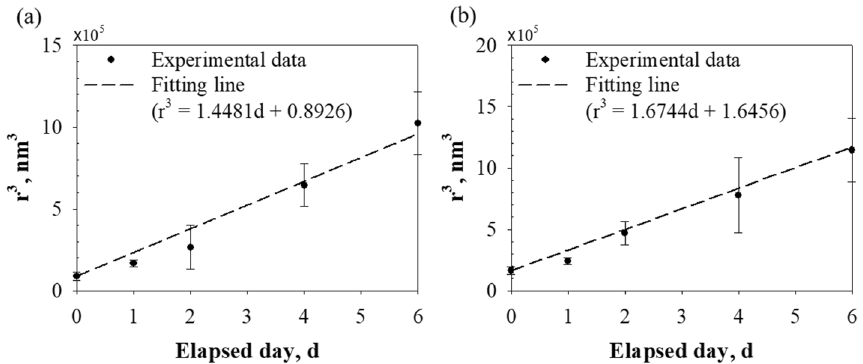
Figure 6. Growth rate of BNBs. (a) Case 1, (b) case 2. The measured cubic radius of NBs increased linearly with time, the same trend predicted by the LSW theory for Ostwald